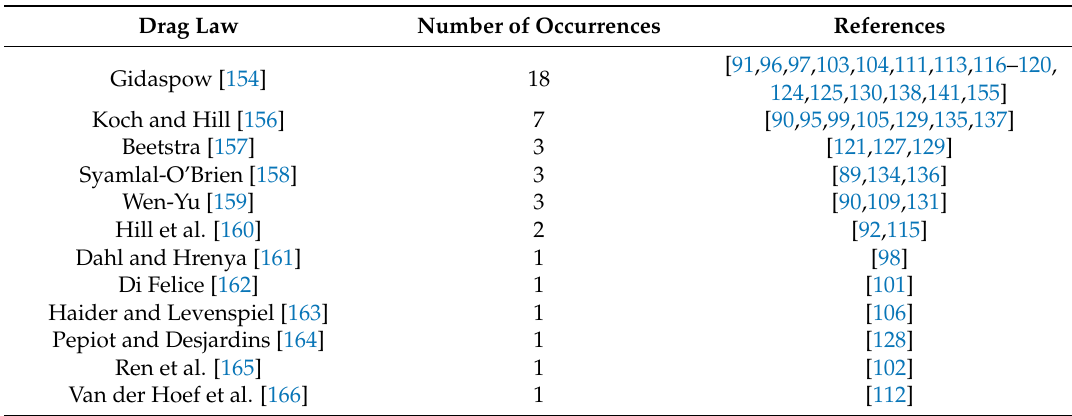
Table 3. Drag models used in DEM